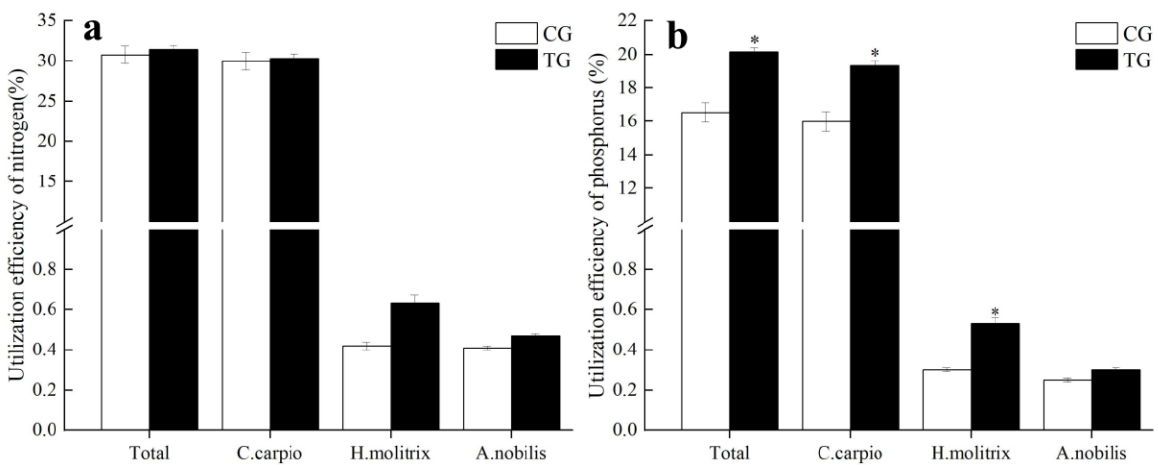
Figure 5. Utilization efficiency of nitrogen and phosphorus by the cultured animals in different groups. ( a ) Nitrogen; ( b ) phosphorus. The data with different letters in the same item showed significant differences (* p < 0.05).